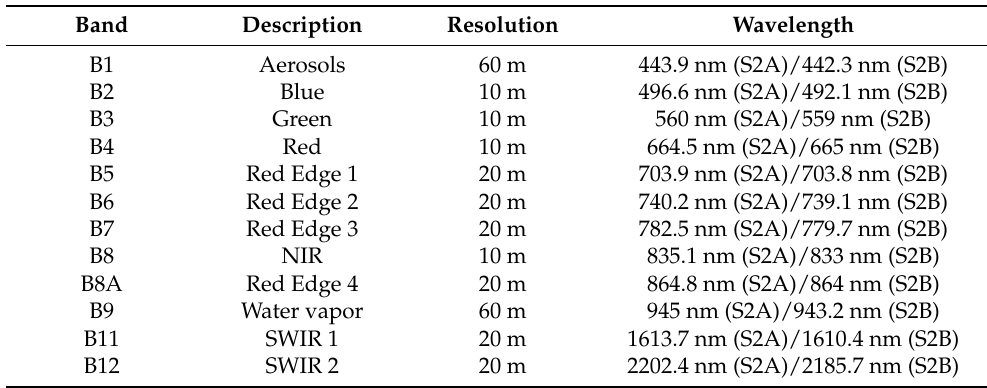
Table 1. Characteristics of Sentinel-2 MSI L2A images.